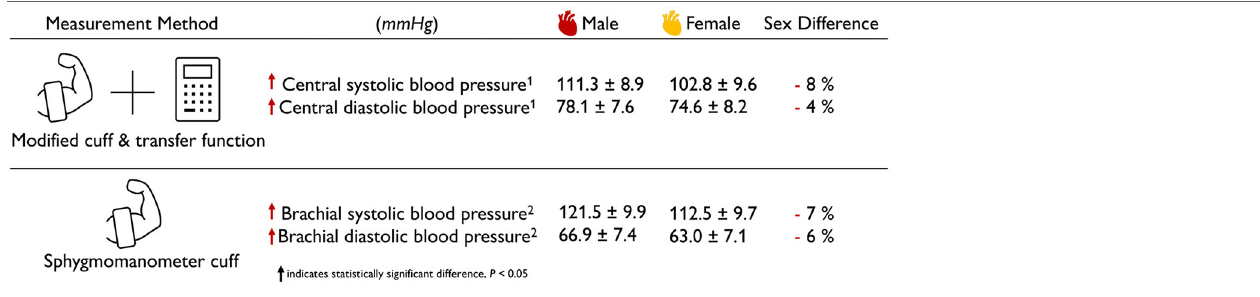
TABLE 6 | Sex differences in athlete’s blood